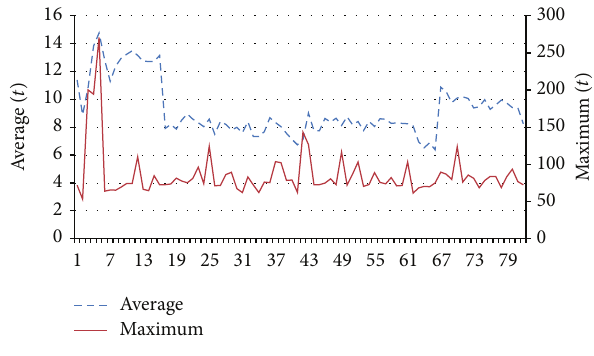
Figure 2: Variability in the mean values and maximum values.